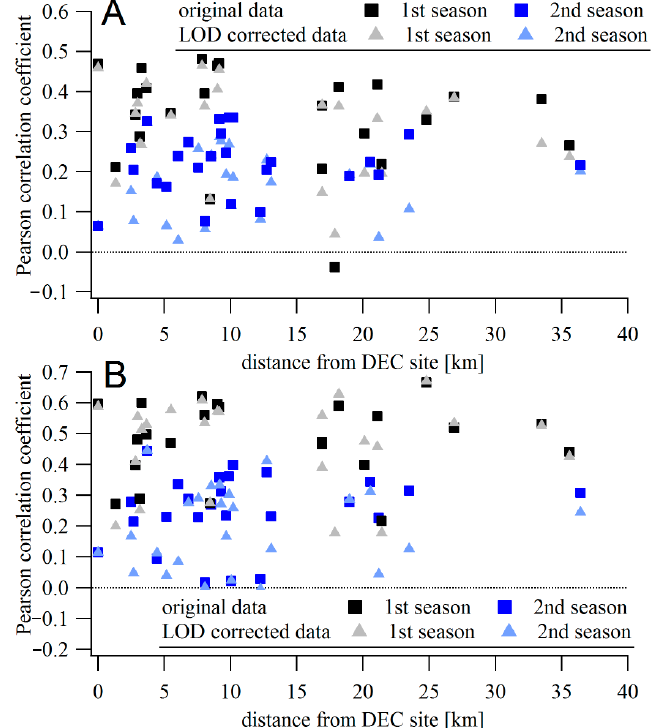
Figure 2. ( A ) Pearson correlation coefficient between hourly averaged concentrations measured by Speck units and TEOM located at the Rochester DEC site, dependent on the distance between Specks and the DEC site. ( B ) The same for daily averages.